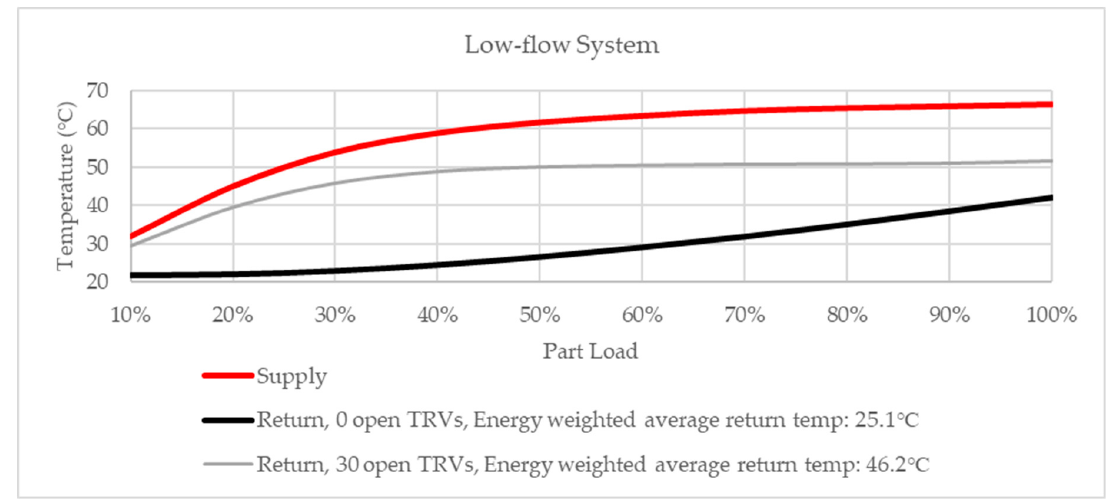
Figure 6. The daily average DH supply and return temperature measured by the energy meter in the substation of the building case study, and the calculated expected DH return temperature due to the ideal operation of the radiator system during 2017.